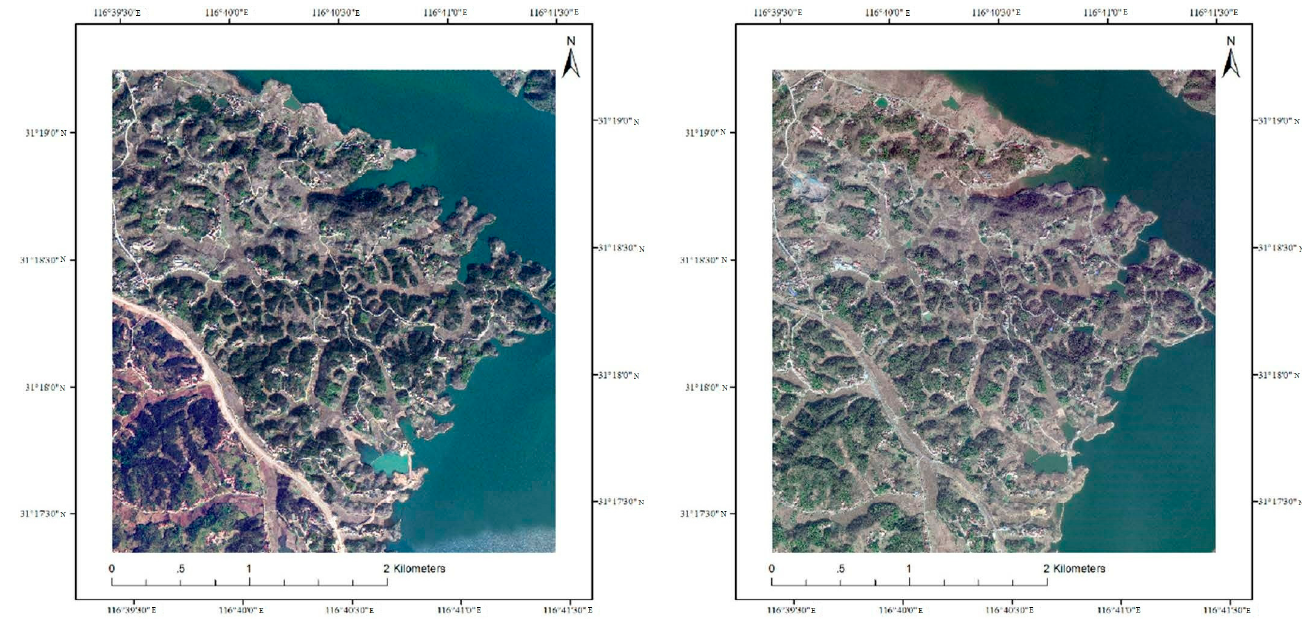
Figure 5. Data of sample